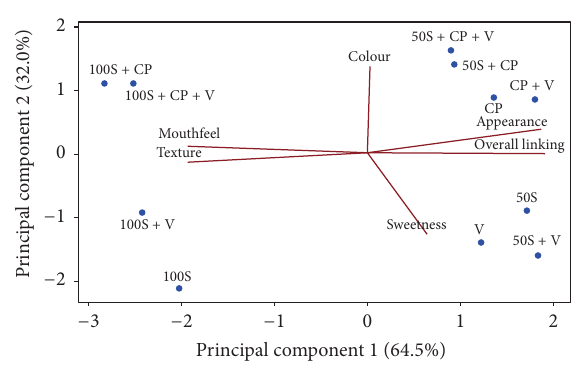
Figure 6: Principal component analysis of muffin attributes. Con- trol (C); vanilla (V); cocoa powder (CP); cocoa + vanilla (CP + V); 50% stevianna (50S); 50% stevianna + vanilla (50S + V); 50% stevianna + cocoa (50S + CP); 50% stevianna + cocoa + vanilla (50S + CP + V); 100% stevianna (100S); 100% stevianna + vanilla (100S + V); 100% stevianna + cocoa (100S + CP); 100% stevianna + cocoa + vanilla (100S + CP +